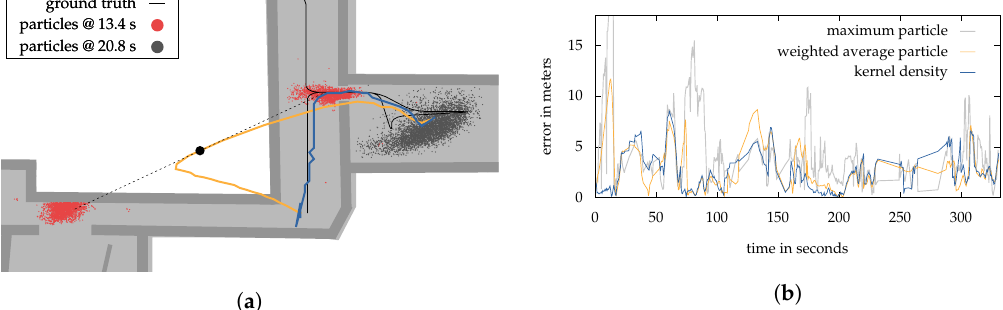
Figure 11. ( a ) Occurring bimodal distribution caused by uncertain measurements in the first 13.4s of walk 1. After 20.8s, the distribution gets unimodal. The weigted-average estimation (orange) provides a high error compared to the ground truth (solid black), while the KDE approach (blue) does not; ( b ) Error development over time for the complete walk. From 230s to 290s to pedestrian was not